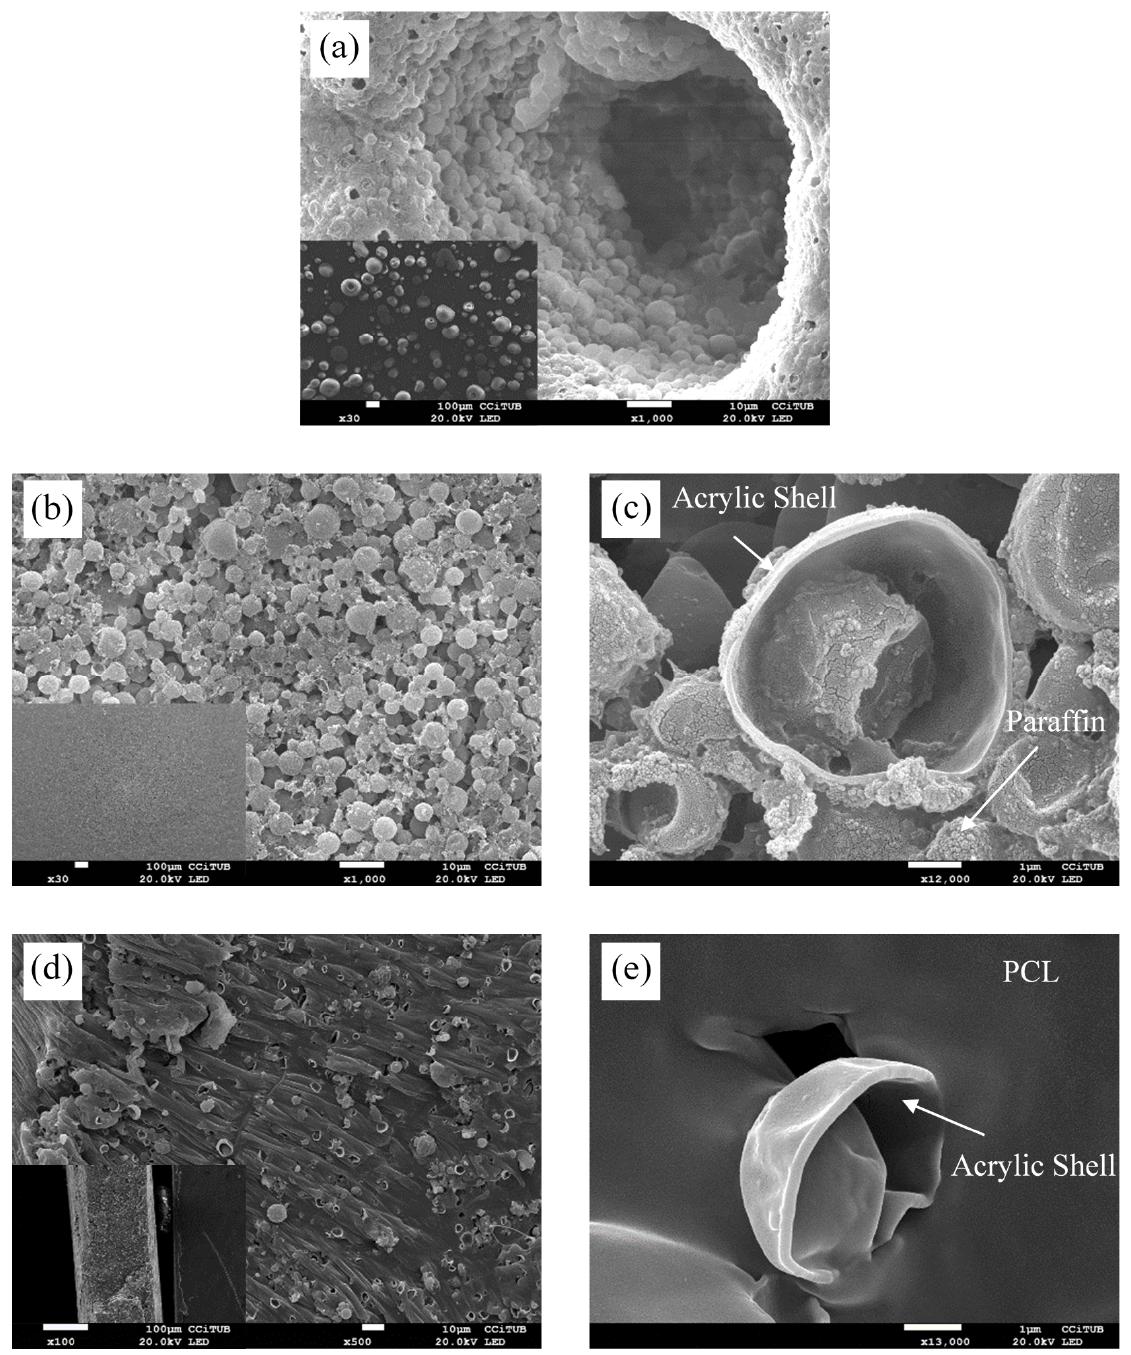
Figure 4. SEM images. ( a ) MPCM; ( b , c ) MPCM_CHCl3_ULTRA; ( d , e ) PCL/MPCM_10. Figures ( a , b , d ) are composed of a general view of the sample and in the down-left corner is included a low magnification image of the same sample.